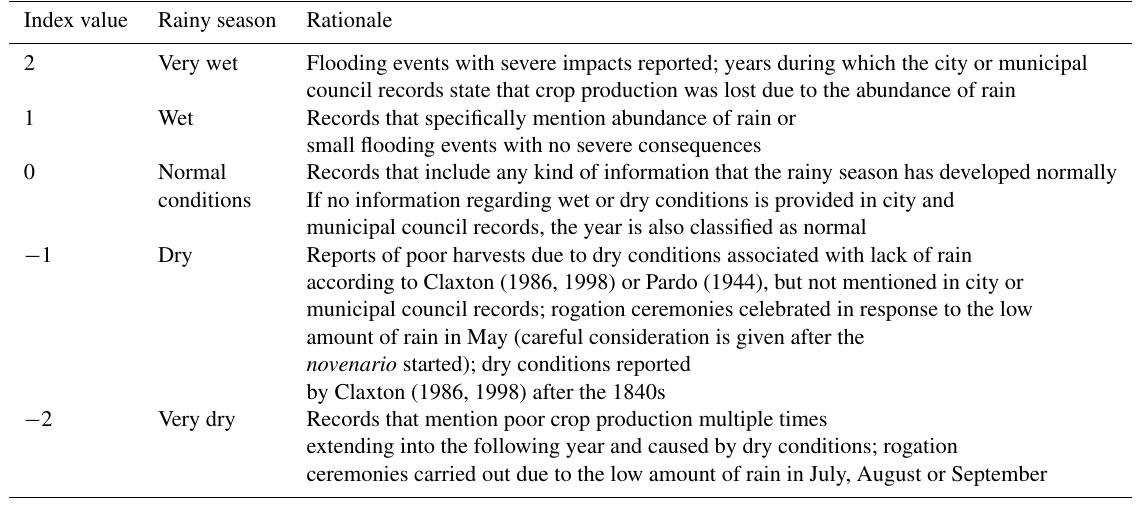
Table 1. Classification of hydrological conditions for the cities of Guatemala and Antigua Guatemala.